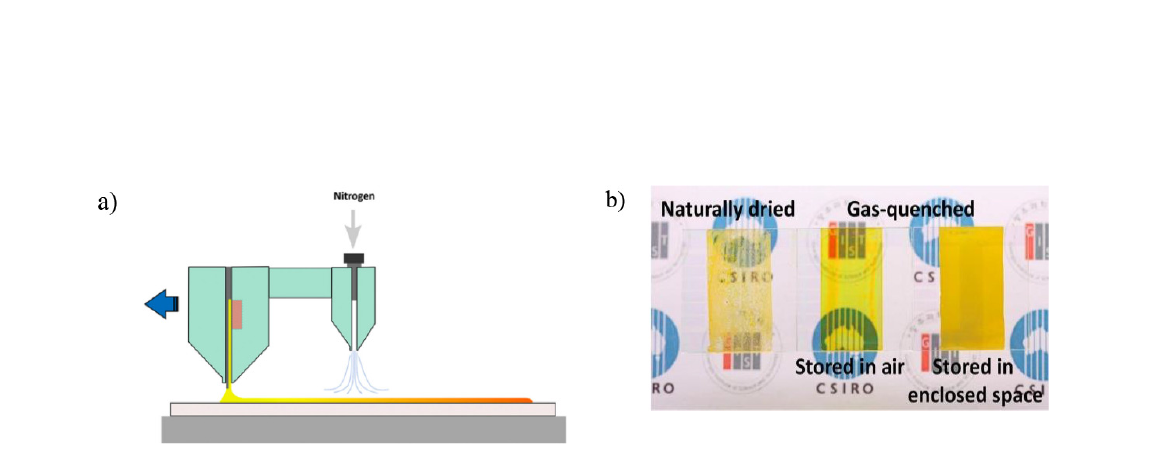
Fig. 17. – (a) Schematic illustration of slot-die coating with a gas-quenching process for the fabrication of pinhole-free PbI2 layer. (b) Photographs of slot-die coated PbI2 films under various coating conditions. The figures are selected from ref.